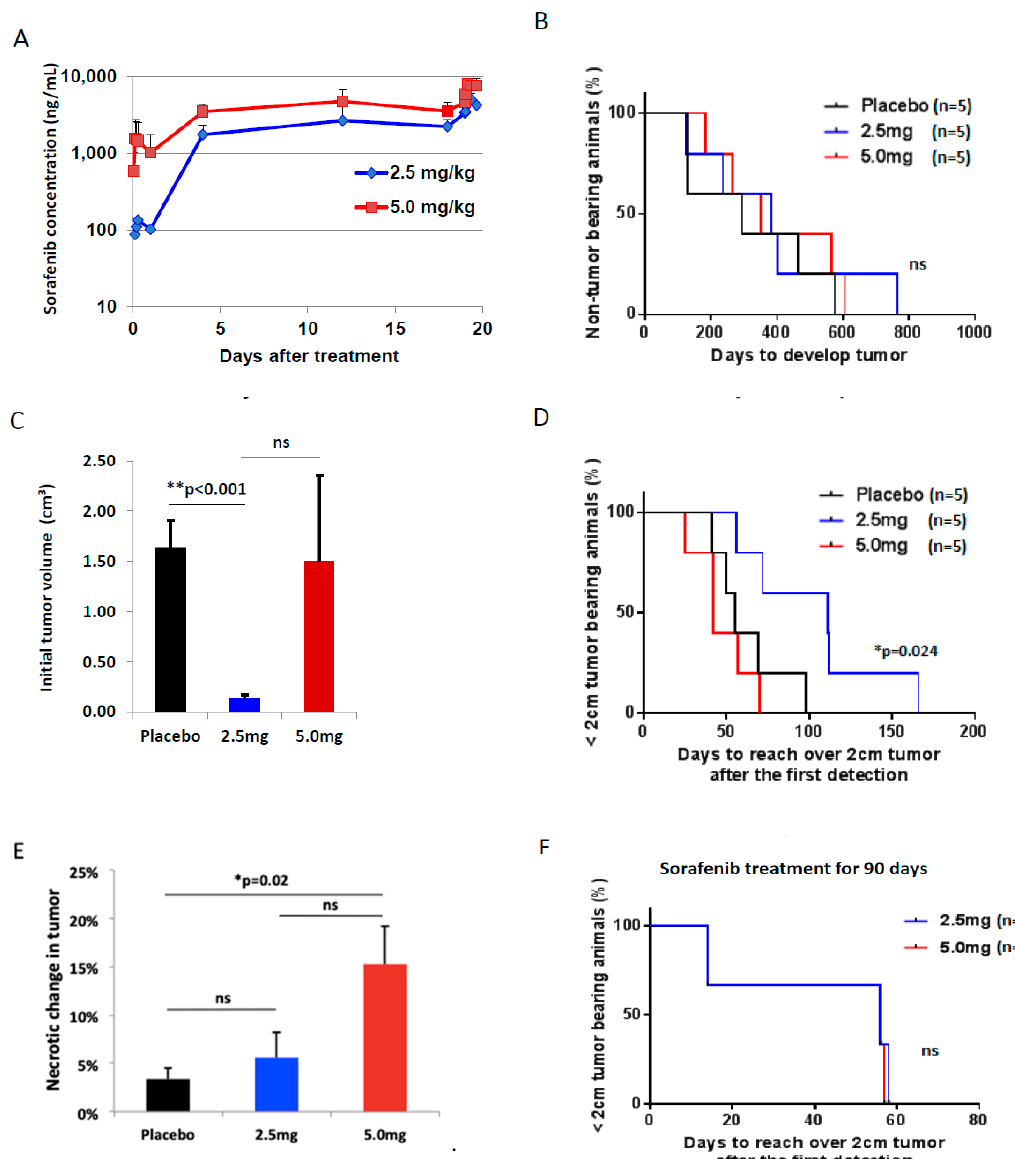
Figure 3. In vivo study with woodchuck hepatitis virus (WHV) infected woodchucks. ( A ) Graph plot of mean sorafenib concentration-time data for the low (2.5 mg / kg) and high (5 mg / kg) dose groups with a 5-days-on and 2-days-o ff schedule. ( B ) percent of non-tumor bearing animals after sorafenib treatment with di ff erent doses of sorafenib ( n = 5), ns; not significant. ( C ) initial tumor volumes when tumor was detected for the first time, ** p < 0.001 by Student’s t -test, ns; not significant. ( D ) percent of less than 2 cm sized tumor bearing animals after the first tumor detection ( n = 5), * p < 0.05 by Log-rank (Mantel-Cox) test. E, percent of necrotic change in tumor after tumor reached over 2 cm. ( F ) percent of less than 2 cm sized tumor bearing animals after a short-term (90 days) usage of 2.5mg / kg or 5.0 mg / kg sorafenib ( n = 3), ns; not